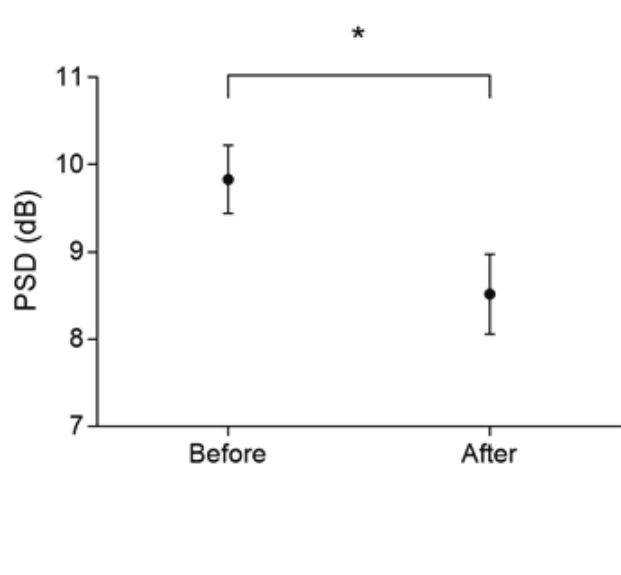
Figure 3. PSD changes before and after using the reversed Galilean telescope. Data are presented as Mean ± SEM ( n = 52 subjects). *Denotes a significant